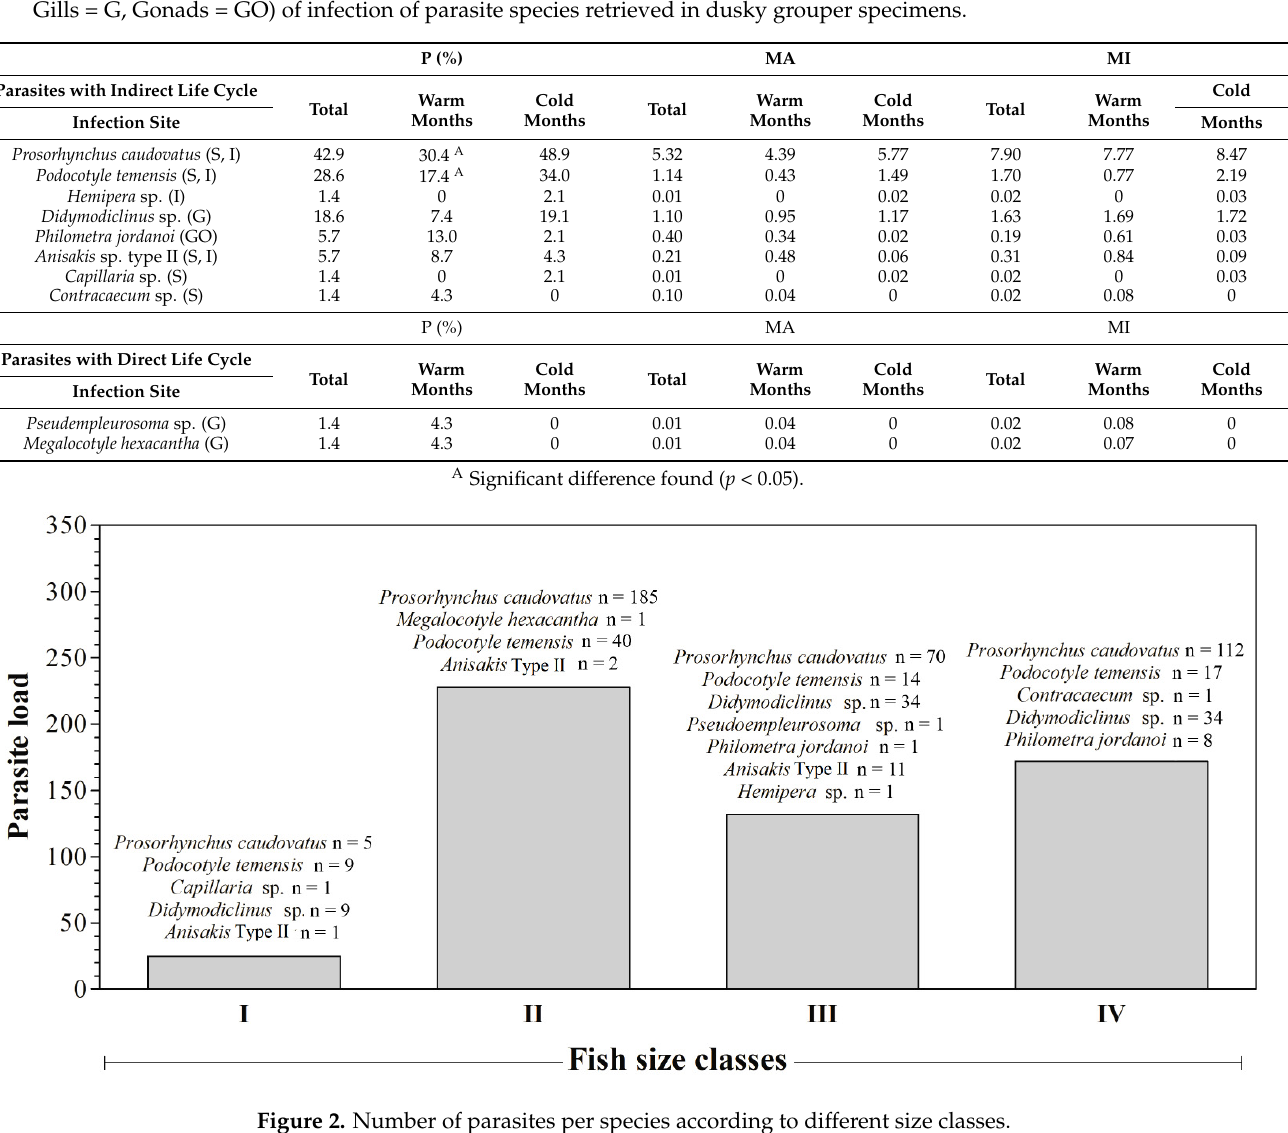
most prevalent parasite species P. caudovatus ( χ 2 = 7.55, p = 0.006) and P. temensis ( χ 2 = 7.61,